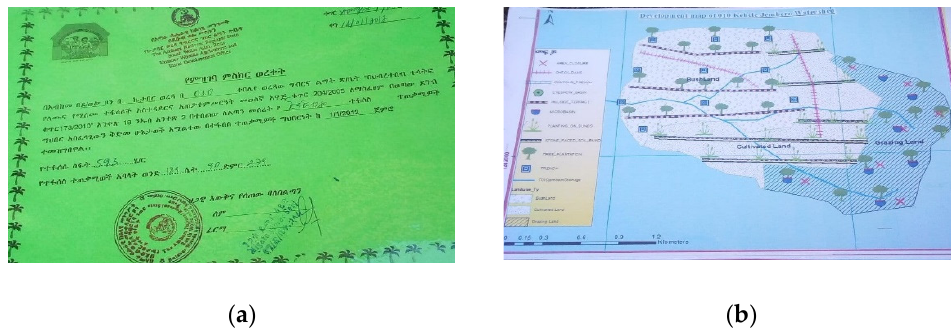
Figure 11. ( a ) Title deed for community watershed, and ( b ) land-use map of visited micro-basins.